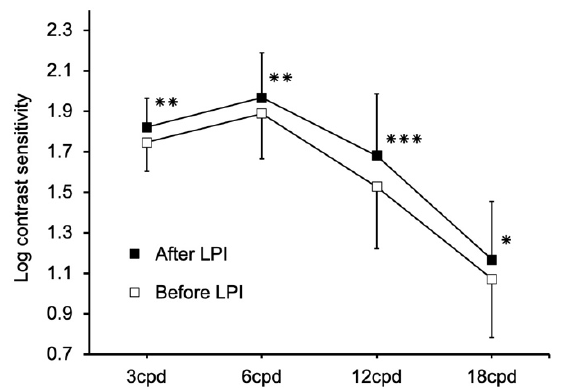
Figure 1. Contrast sensitivity at four specific frequencies before and after lacrimal passage obstruction. Treatment resulted in significant increases in contrast sensitivity at all spatial frequencies from 3 to 18 cycles/degree ( p < 0.01 for 3 cycles/degree, p < 0.01 for 6 cycles/degree, p < 0.0005 for 12 cycles/degree, p < 0.05 for 18 cycles/degree). Values are expressed as the mean ± standard deviation. * p < 0.05, ** p < 0.01, *** p < 0.0005